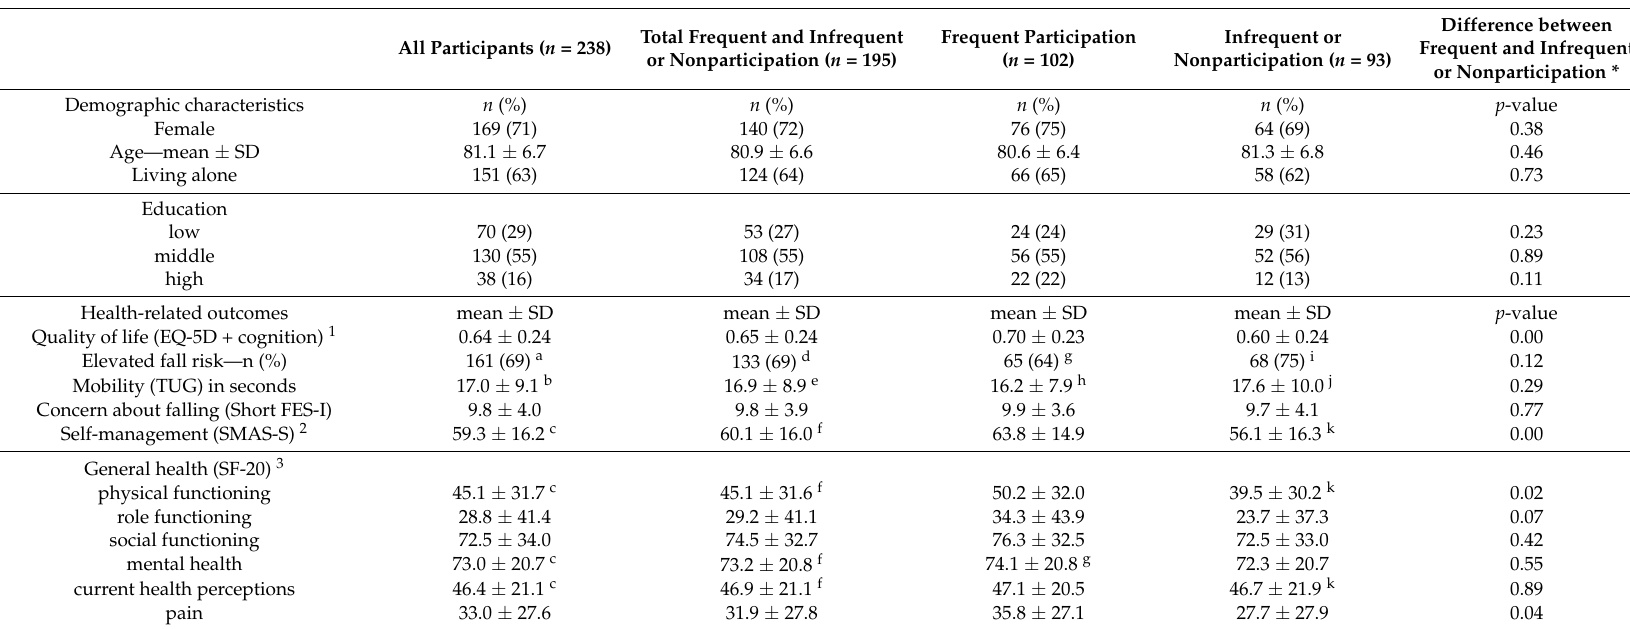
Difference between Total Frequent and Infrequent Frequent Participation Infrequent or All Participants ( n = 238) Frequent and Infrequent or Nonparticipation ( n = 195) ( n = 102) Nonparticipation ( n = 93) or Nonparticipation *